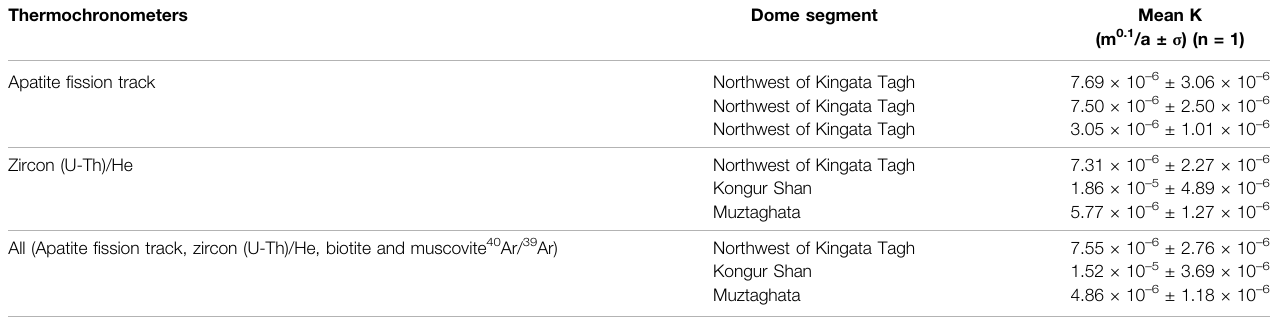
TABLE 1 | Average erodibility coef fi cient ( K ) for northern Kingata Tagh, Kongur Shan, and Muztaghata massifs. Thermochronology data and exhumation rates are from Thiede et al. (2013). Thermochronometers